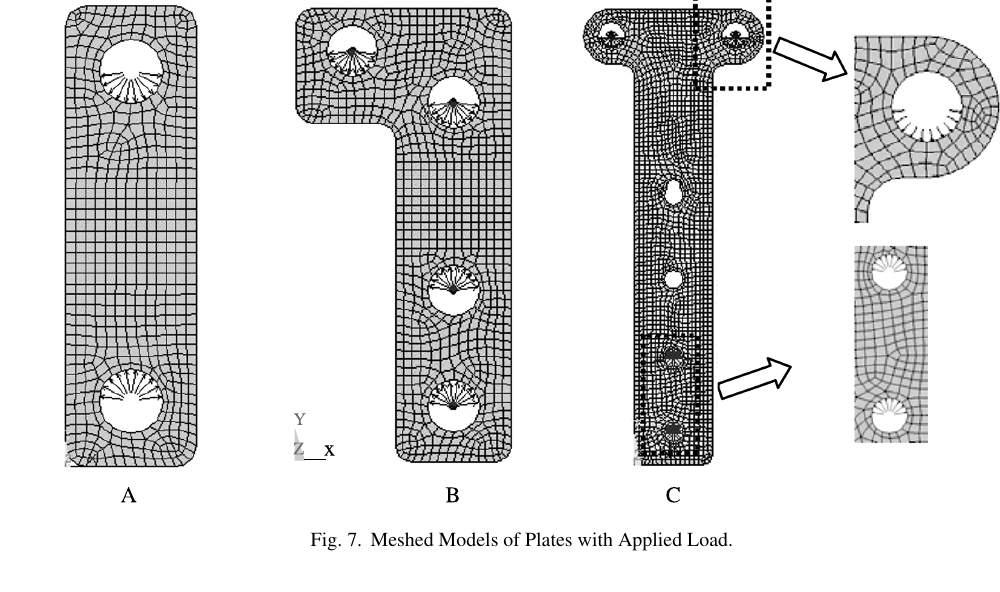
Fig. 7. Meshed Models of Plates with Applied Load.